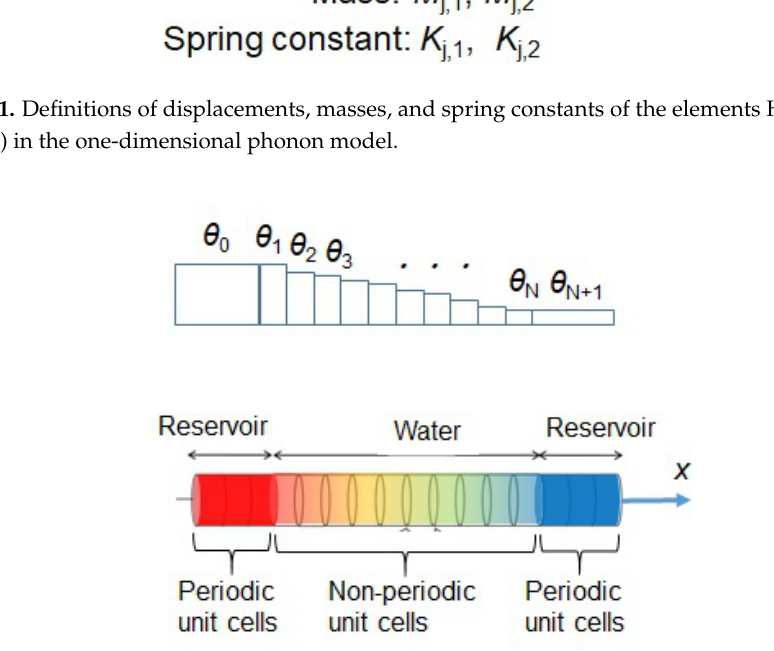
Figure 2. One-dimensional phonon model of reservoir-water-reservoir structure. Each unit cell j has length l j , ( j = − N L + 1, − N L + 2, · · · N + N R ) along the x-direction and temperature θ j , ( j = 0,1,2, · · · N + 1), where θ − N